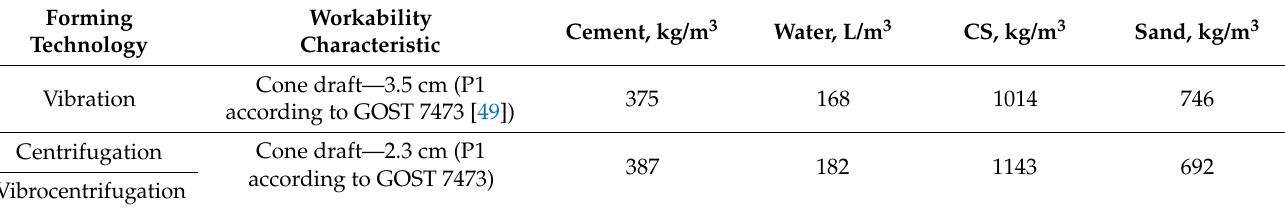
Table 4. Proportions of mixtures and their